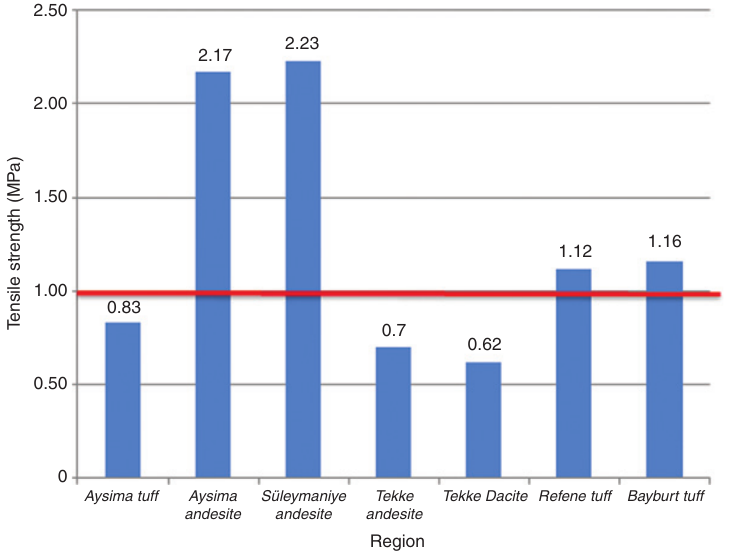
Figure 2 Tensile strength values of the samples at the end of 7 days and limit value according to TS 25.